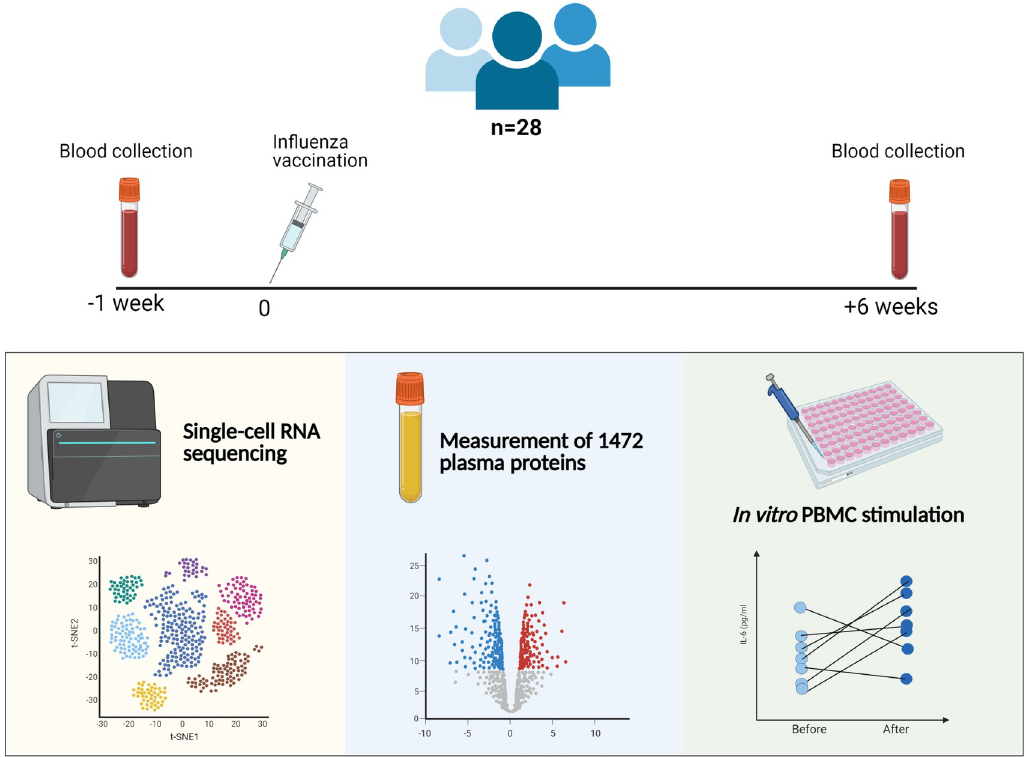
Fig 1. Summary of the clinical study investigating the effects of an influenza vaccine on trained immunity. Blood was collected 1 week before and 6 weeks after the influenza vaccination from 28 participants. PBMC stimulation, quantification of plasma proteins, and single-cell RNA sequencing were